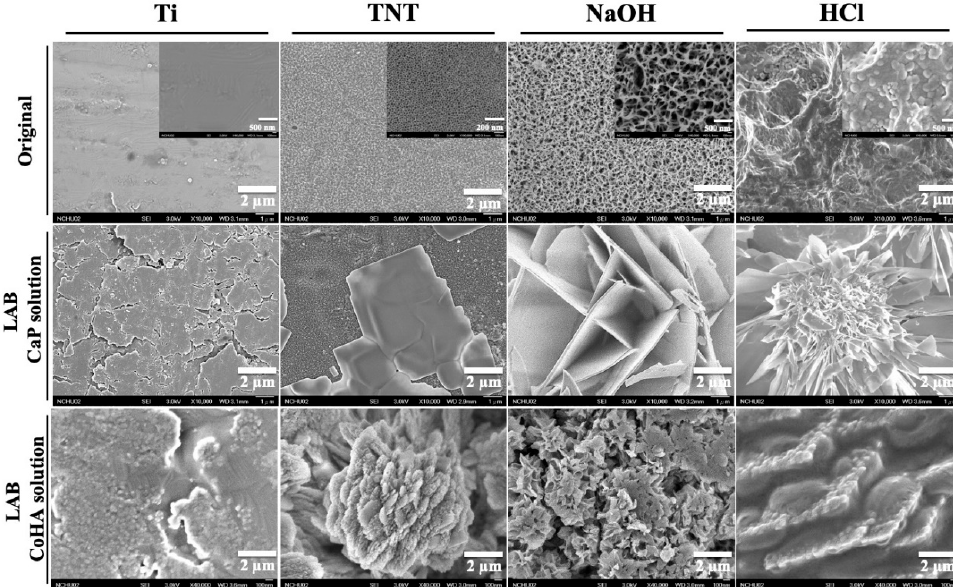
Figure 2. Surface topography of the titanium sheet with different surface treatments and samples after LAB treatments (calcium-to-phosphorus (CaP) solution and cobalt-substituted hydroxyapatite (CoHA) solution) by SEM.